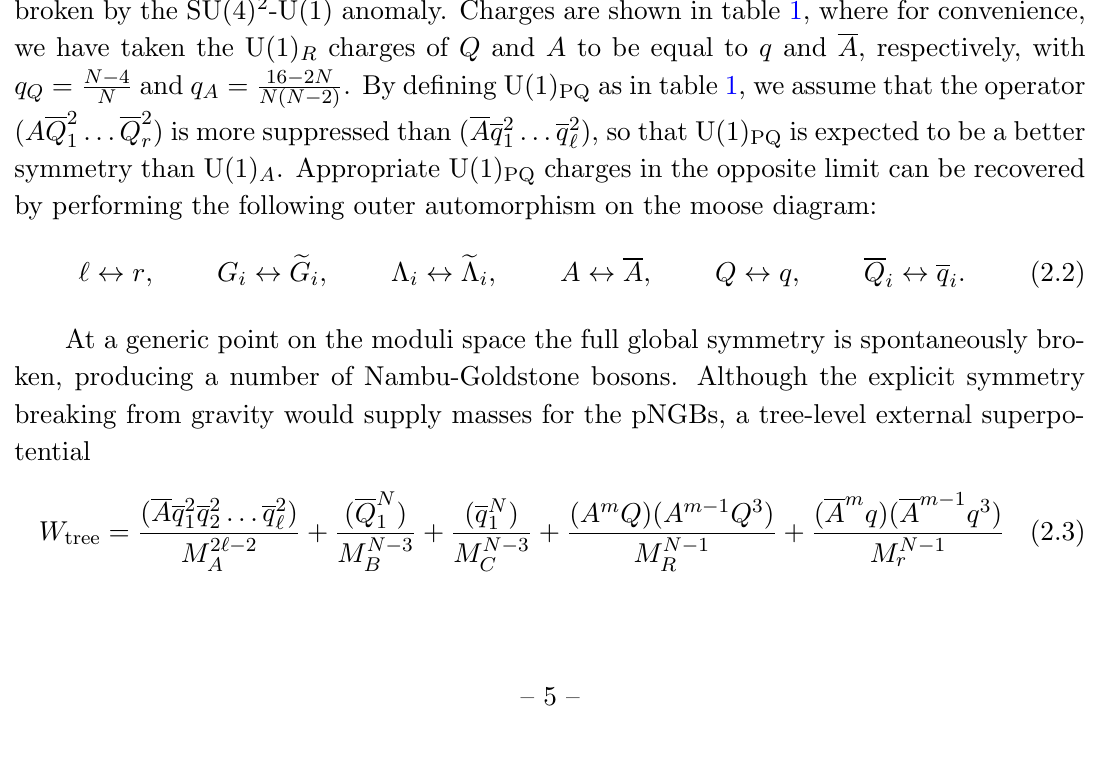
G i corresponds to a gauged SU( N ), whereas e